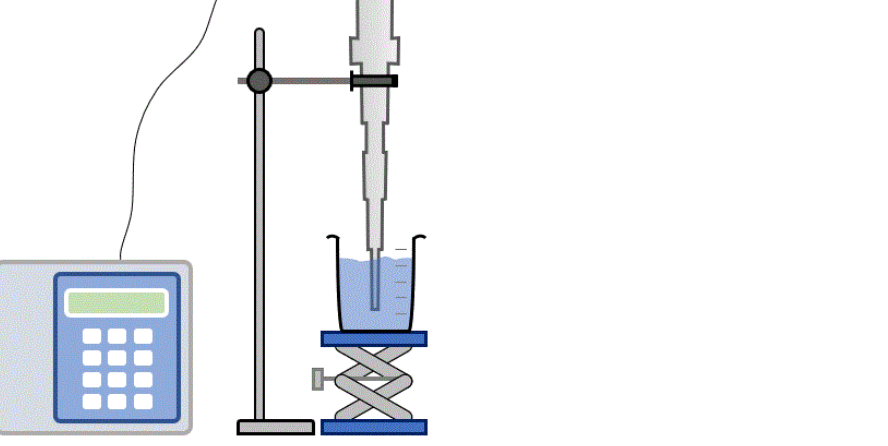
Figure 9. Scheme of the reactor used for the study of PMS activation by ultrasounds.